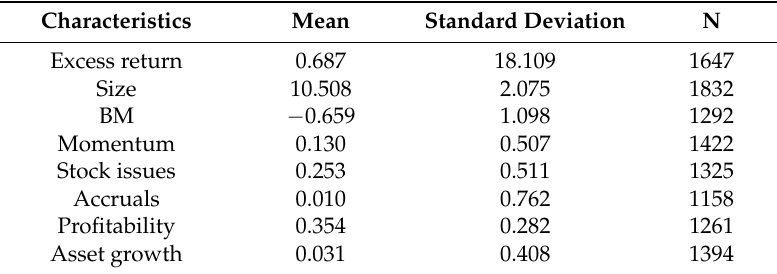
Table 1. Summary